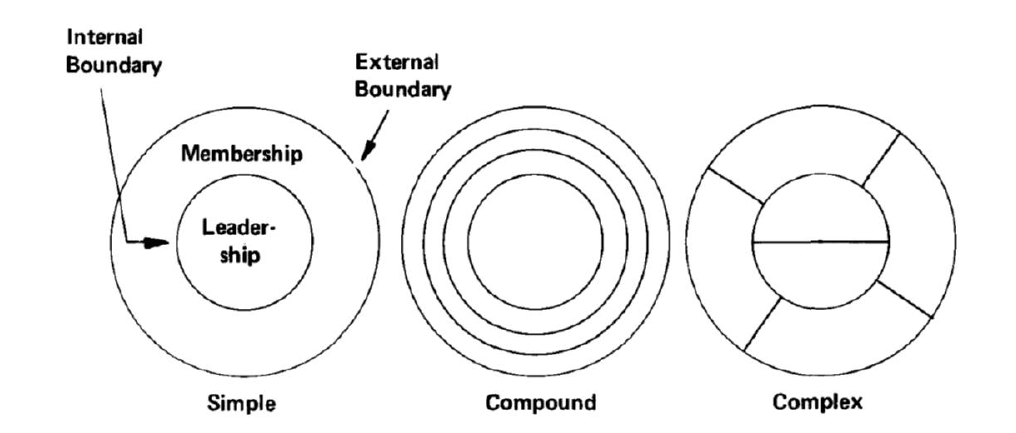
Figure 17: Structural diagrams. (Fox, 1975 p.349)